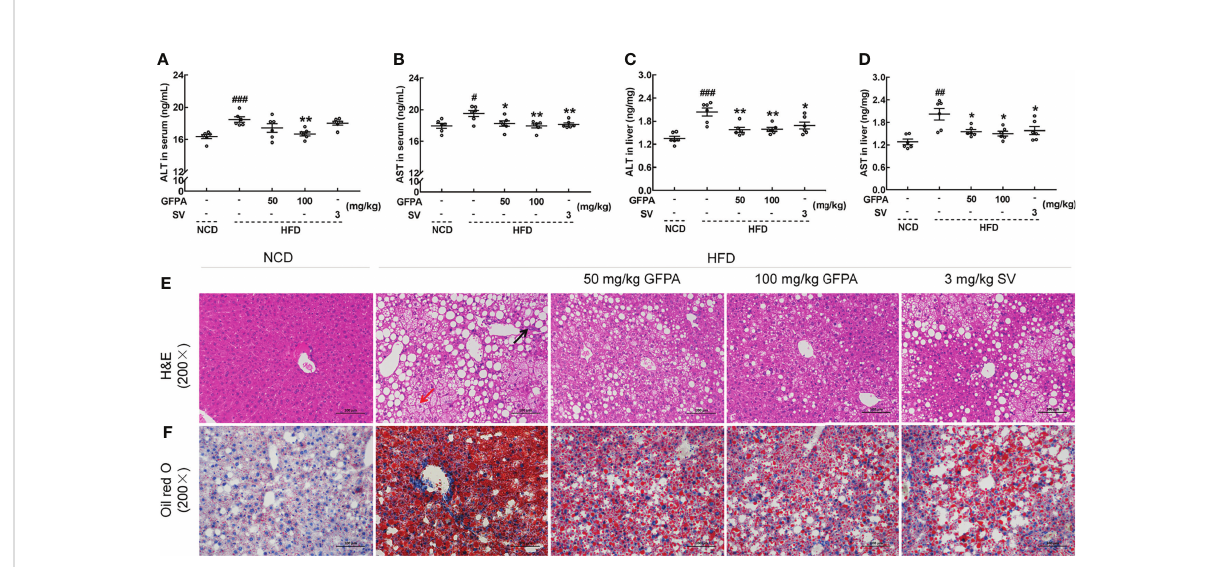
FIGURE 4 GFPA alleviated hepatic steatosis in mice with DIO. In HFD-fed mice, GFPA suppressed the serum concentrations of (A) ALT and (B) AST and the hepatic concentrations of (C) ALT and (D) AST. Data are expressed as means ± S.E.M. (n = 6). # p < 0.05, ## p < 0.01 and ### p < 0.001 versus NCD-fed mice; * p < 0.05 and ** p < 0.01 versus HFD-fed mice. Pathological alterations in the liver were evaluated by (E) H&E staining (magni fi cation: 200×; scale bar: 50 m m) and (F) Oil red O staining (magni fi cation: 200×; scale bar: 50 m m). The black arrow indicates the in fl ammatory in fi ltration of lymphocytes in HFD-fed mice, and the red arrow indicates ballooning degeneration, cytoplasmic vacuolation and cellular swelling in HFD-fed